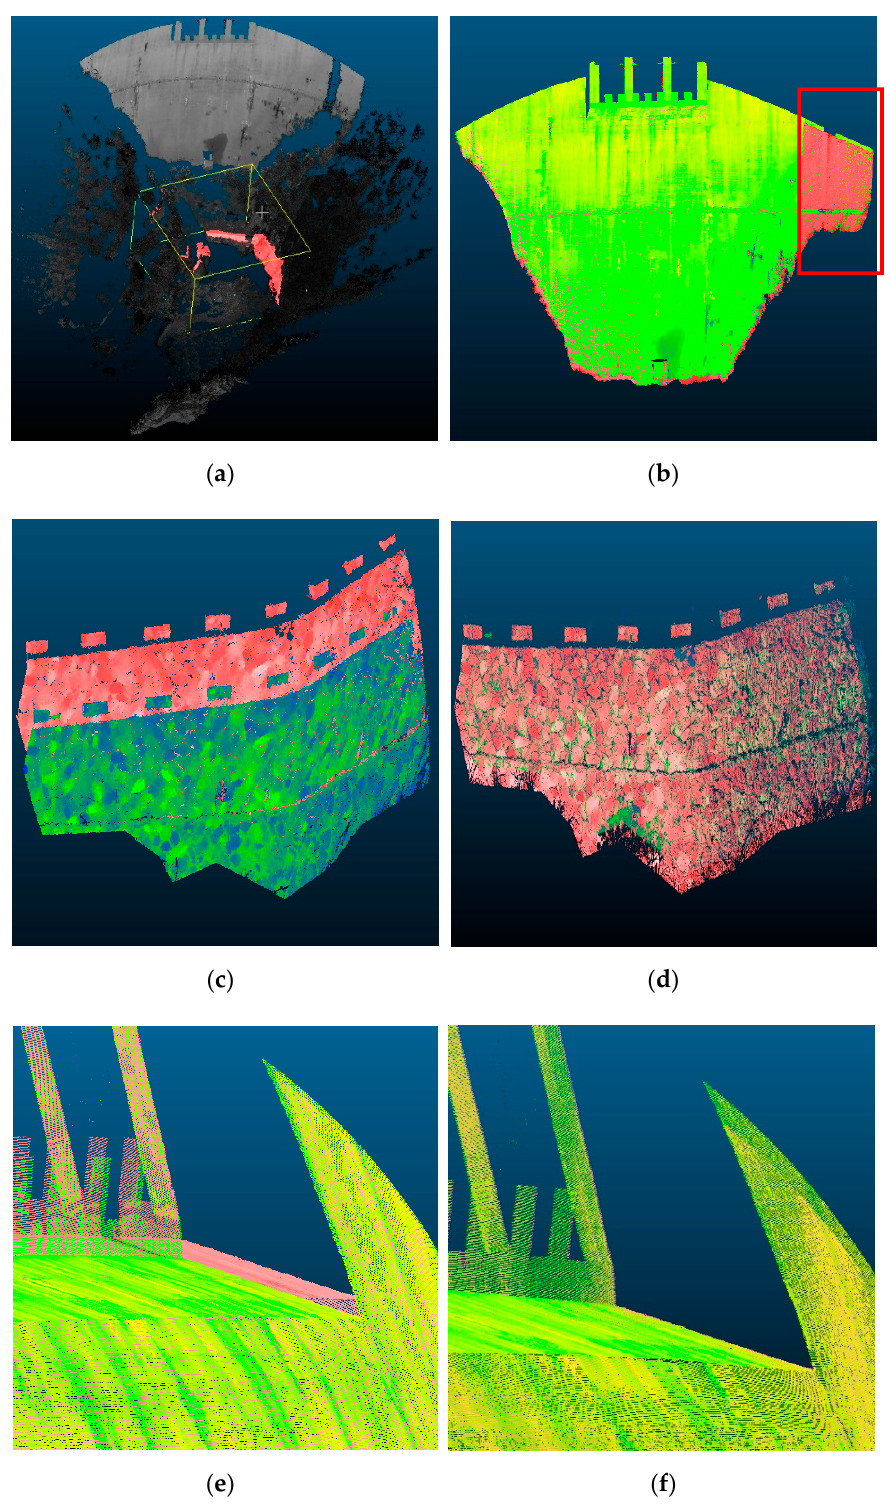
Figure 5. Two registrations based on the complete point cloud and rock mass point cloud. ( a ) The rock mass in front of the dam used for secondary precision registration; ( b ) two-stage dam surface point cloud after the second fine registration and classification; ( c ) two-stage rock mass point cloud for the first rough registration; ( d ) two-stage rock mass point cloud for the second fine registration; ( e ) part of the point cloud of the two dam faces after the first rough registration; and ( f ) part of the point cloud of the two-stage dam surface after the second fine registration.